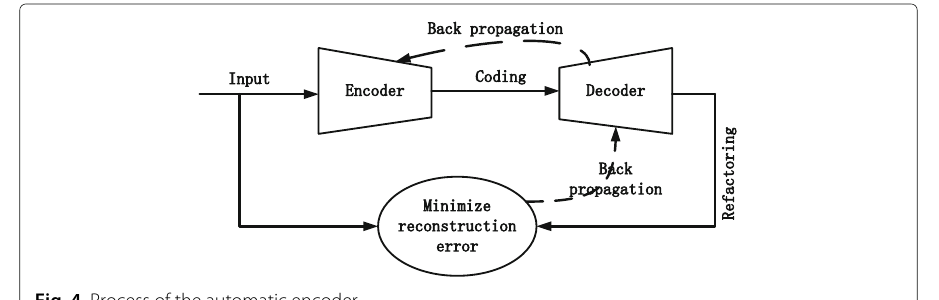
Fig. 4 Process of the automatic